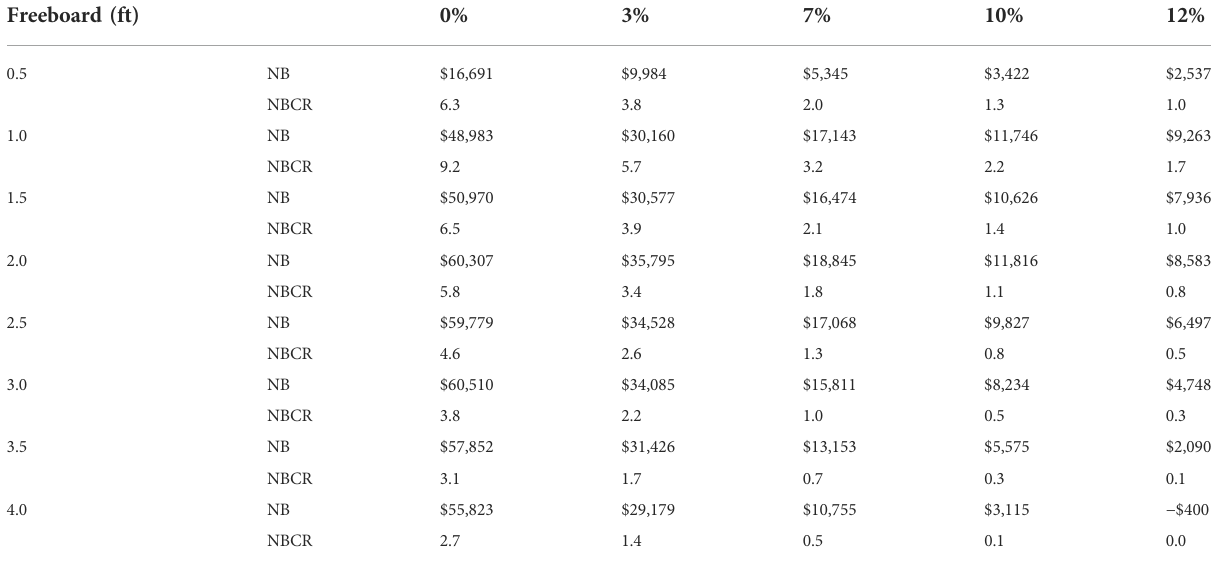
TABLE 5 Results of life-cycle bene fi t-cost analysis as shown by net bene fi t (NB) and net bene fi t-cost ratio (NBCR) calculated as an upfront construction cost, by freeboard scenario and real discount rate. Freeboard (ft)